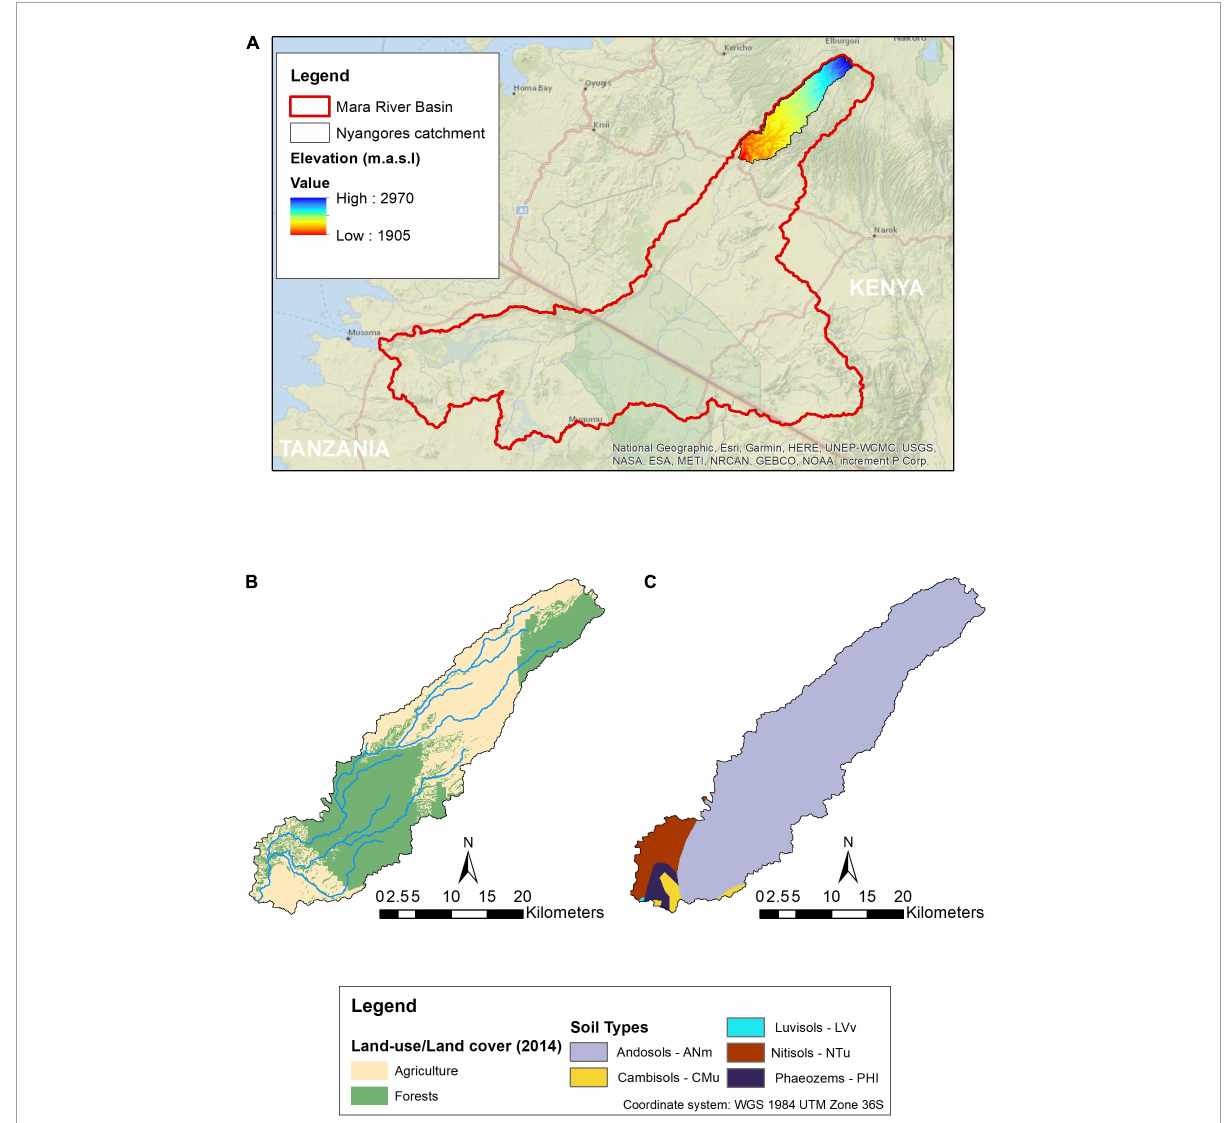
FIGURE1 Nyangores catchment (A) location and elevation, (B) land-use/land cover, and (C) soil types.